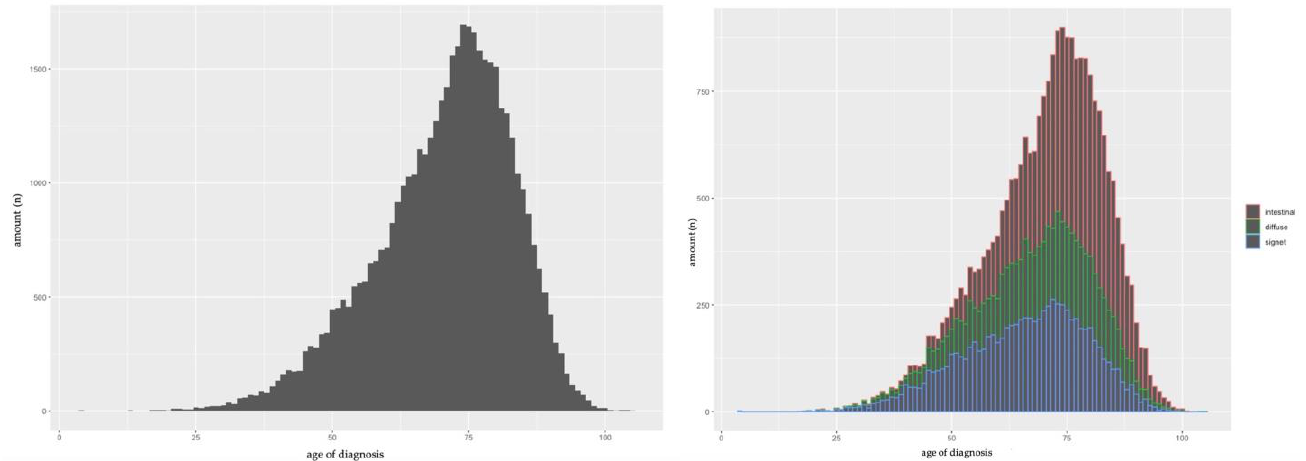
Figure 1. Gastric cancer population. Left: dispersion by age. Right: dispersion by age and histopathology; red = intestinal type, green = diffuse type, blue = signet type.